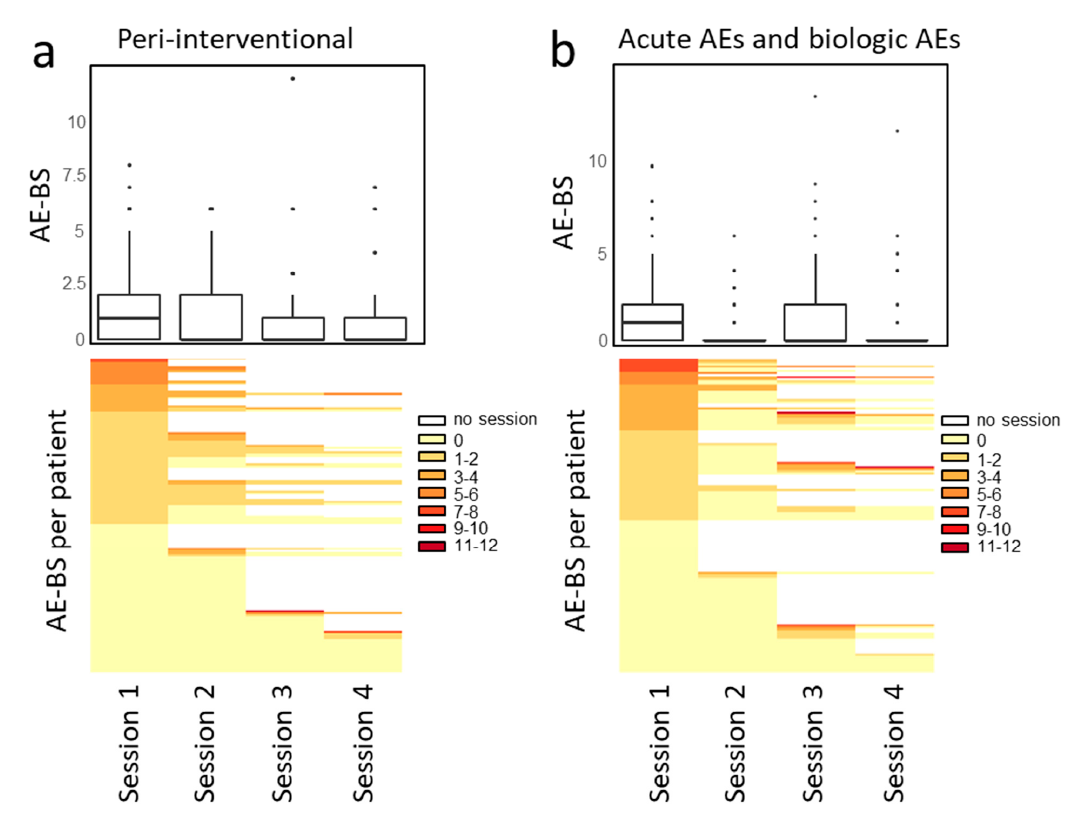
Figure 2. AE-BS per treatment session for peri-interventional ( a ) and acute and biologic AEs ( b ). The AE-BS represents the sum of all AE grades per patient. The boxplots show the AE-BS per treatment session for all patients and the heatmaps show the AE-BS per treatment session for each patient. Each row represents one patient. No clustering was used but the scores were sorted by descending AE-BS. White fields indicate no session was performed.